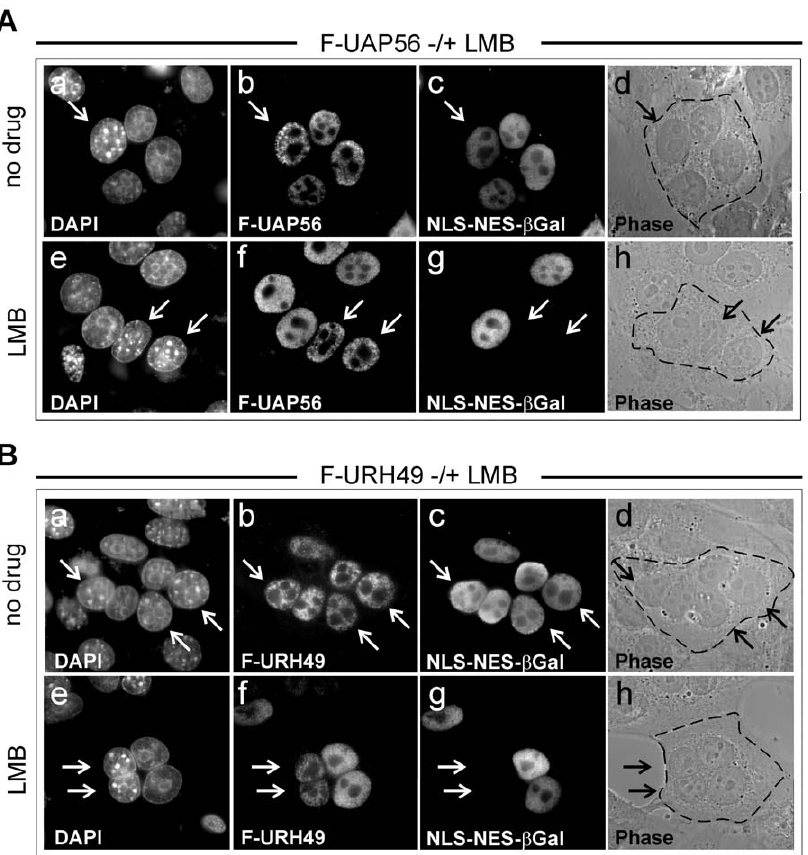
Figure 3. CRM1-independent shuttling activity of UAP56 (A) and URH49 (B). (A + B) Heterokaryon assay: Effect of LMB on shuttling of FLAG- UAP56 or FLAG-URH49 as determined by interspecies heterokaryon analysis. HeLa cells were cotransfected with expression constructs for FLAG- UAP56 (A) or FLAG-URH49 (B) in combination with the plasmid CFNrev- b Gal. Three hours prior to fusion and throughout the experiment, cells were incubated in the absence (a–d) or presence of 2.5 ng/ml leptomycin B (LMB; panels e–h). Two hours after fusion, proteins were detected by indirect immunofluorescence analyses essentially as described in the legend of Figure 2. Murine nuclei are indicated by arrows.